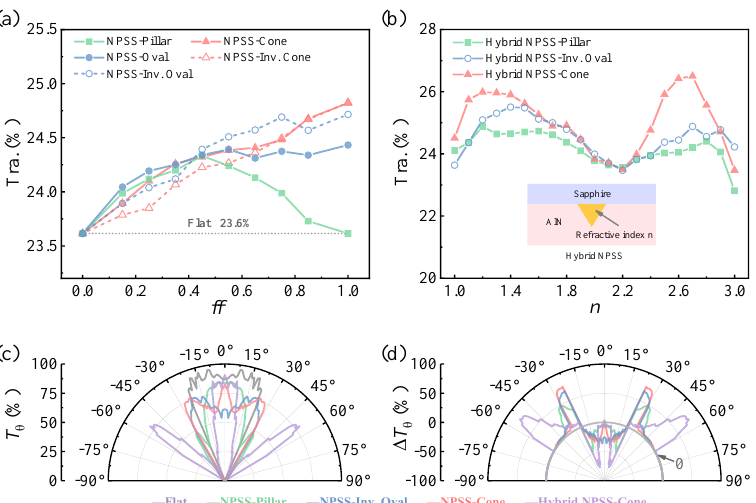
Figure 6. ( a ) The average transmittance Tra. for the five related cases under the different fill factors, where the respective optimal period P and height H were adopted. ( b ) The average transmittance Tra. of the three related cases as a function of refractive index n , where the NPSS structures were filled by the pseudo materials with the fixed refractive index. Incident angle-dependent ( c ) Tra. and ( d ) Tra. difference for the related cases.